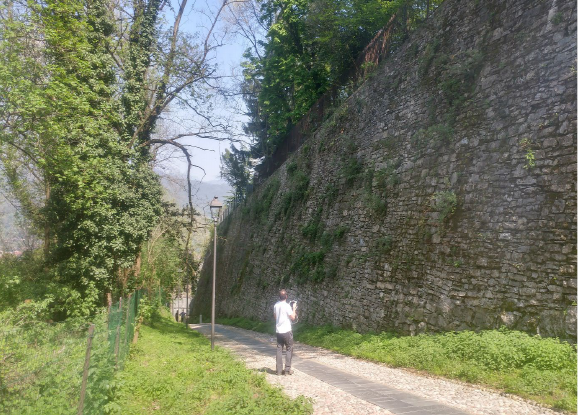
Figure 4. Digital pictures acquisition with Phantom IV DJI.